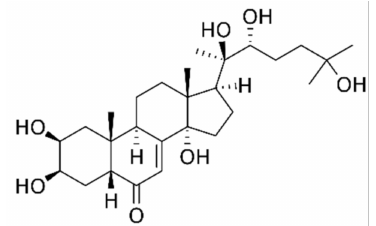
Figure 3. 20-hydroxyecdysone